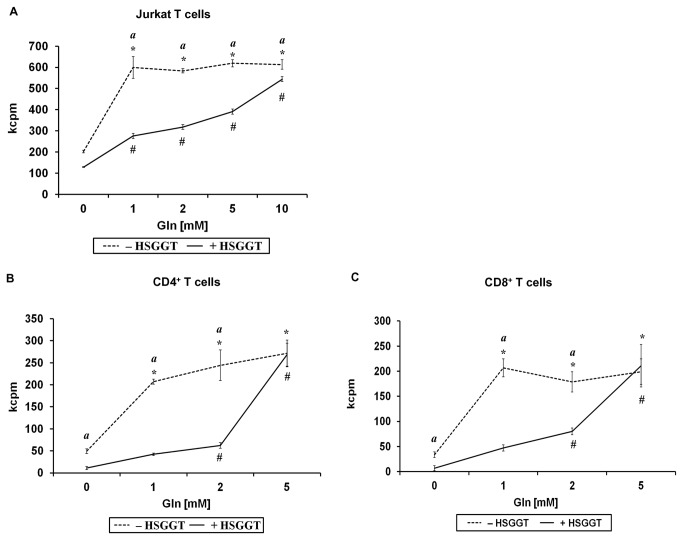
The role of L-Gln supplementation to H. suis γ-glutamyl transpeptidase (GGT)-treated Jurkat T cells and murine splenocytes.Jurkat T cells were incubated in medium supplemented with L-Gln (0 mM to 10 mM) for 72 hours (A) in the presence or absence of 2 µg/mL recombinant H. suis GGT, followed by cell proliferation detection by determining [3H]-thymidine uptake. CD4+ T cells (B) or CD8+ T cells (C) activated by anti-CD3 and anti-CD28 mAbs, were supplemented with L-Gln (0 mM to 10 mM) for 68 hours in the presence or absence of 1 µg/mL recombinant H. suis GGT, followed by cell proliferation detection by measuring [3H]-thymidine uptake. The mean data (± SD) of one representative experiment (out of 3 performed in total) are shown for A-C (n=3). * and # represent a statistically significant increase (p < 0.05 ) of cell proliferation by supplementing cells with a given L-Gln concentration, compared to HBSS- or H. suis GGT-treated cells, respectively, without L-Gln supplementation (0 mM L-Gln) (one-way ANOVA). An (a) indicates a higher proliferation rate of HBSS-treated cells, compared to H. suis GGT-treated cells for a given L-Gln concentration (Student t test). *, #, and (a): p < 0.05. kcpm: the number of counts per minute (x1000) determined by β-scintillation counting, as a measure of cellular proliferation; HSGGT: recombinant H. suis GGT; CD3/CD28 mAbs: anti-mouse CD3/CD28 monoclonal antibodies; Gln: L-glutamine; -HSGGT: treated without recombinant H. suis GGT; +HSGGT: treated with recombinant H. suis GGT.